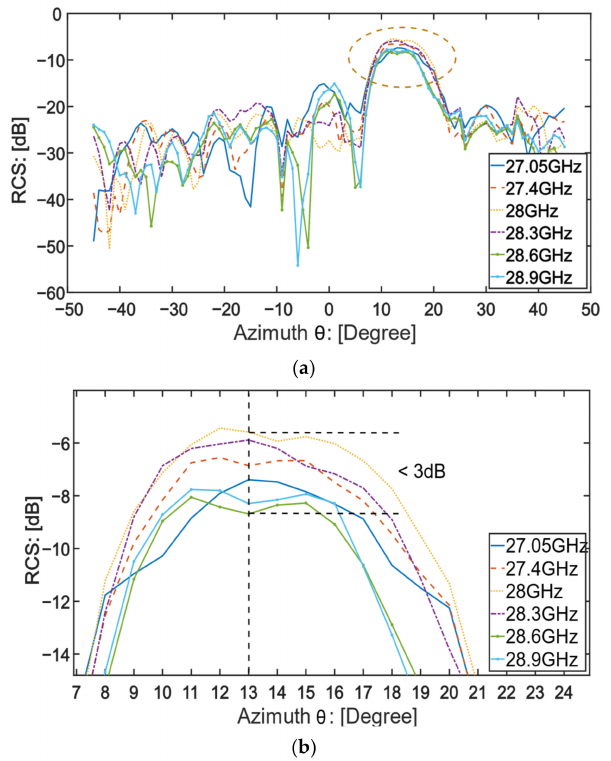
Figure 8. Bandwidth of single beam within − 3 dB gain. ( a ) From 27.05 GHz to 28.9 GHz, the main beam remains very close. ( b ) Zoom in on the dashed circle of ( a